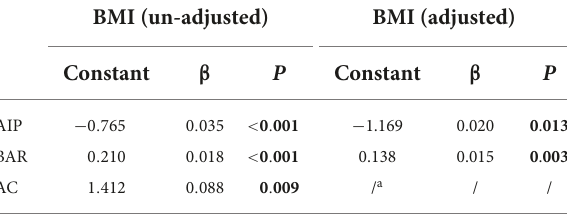
TABLE 3 Independent correlation analysis of cardiovascular risk predictors with BMI.